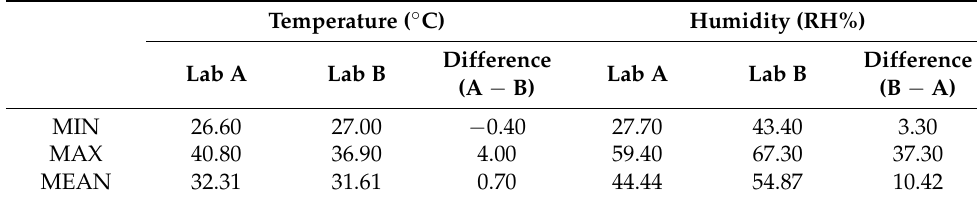
Figure 8. Experiment 2: ( a ) Indoor temperature comparison; ( b ) indoor humidity comparison. Table 7. Comparison of Experiment 2.